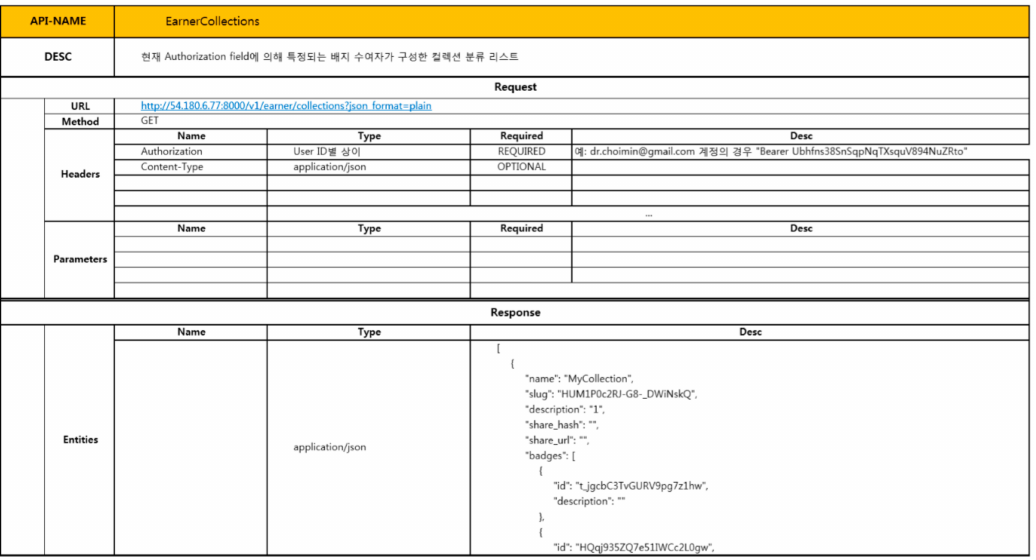
Figure 12. REST API for listing earner